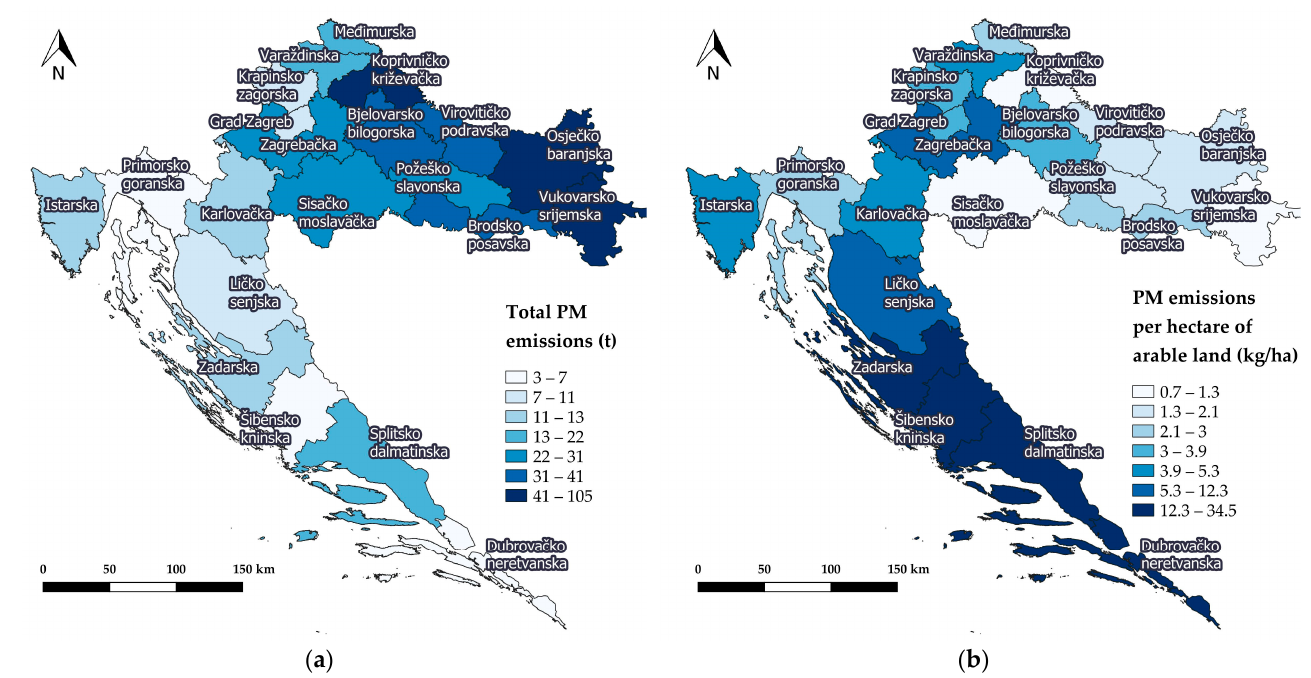
Figure 9. Spatial distribution of total particulate matter (PM) emissions ( a ) and spatial distribution of PM emissions per hectare of arable land ( b ).